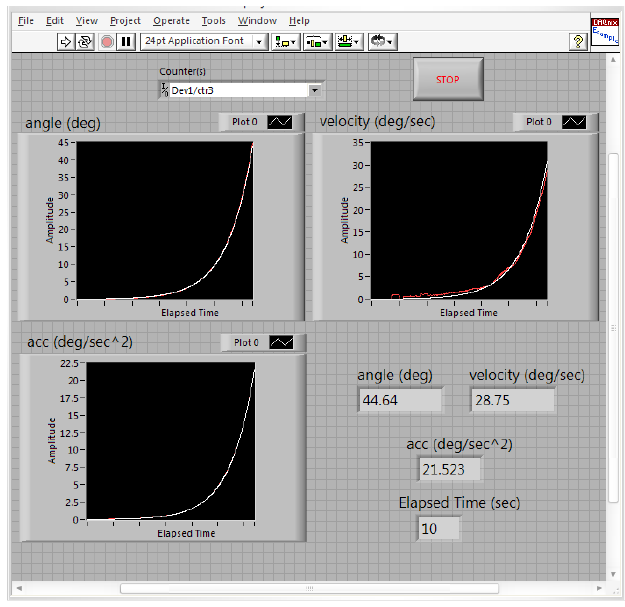
Figure 17. The values of the estimated and measured angular position, velocity and acceleration of the first joint angle (white: estimated, red: measured).